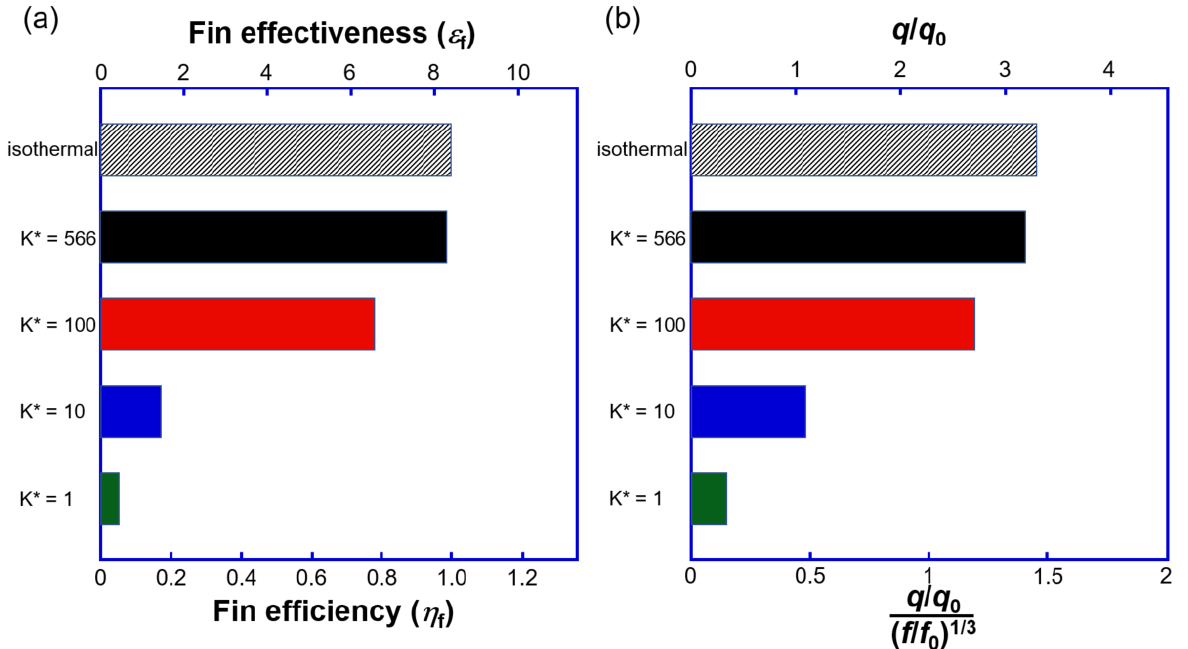
Figure 11. Thermal performance: (a ) fin performance of the rib and ( b ) the total heat transfer rate.